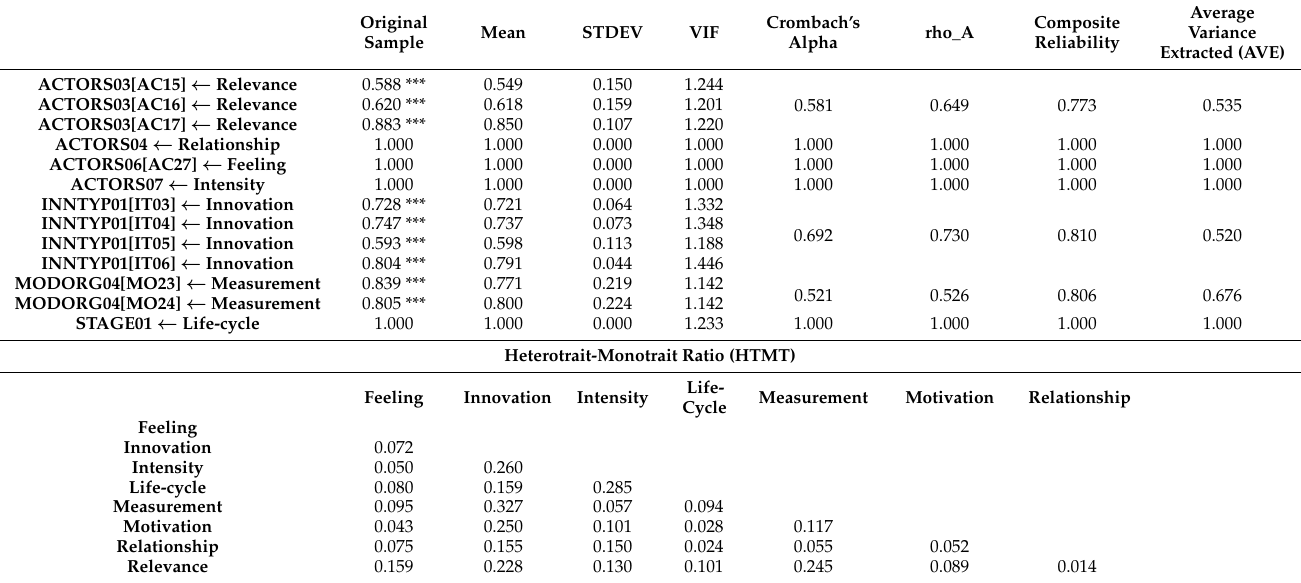
Table A3. Path coefficients, variance inflation factors (VIFs), internal consistency reliability, convergent validity, and discriminant validity measures of reflective (mode A) criteria and their 13 indicators.